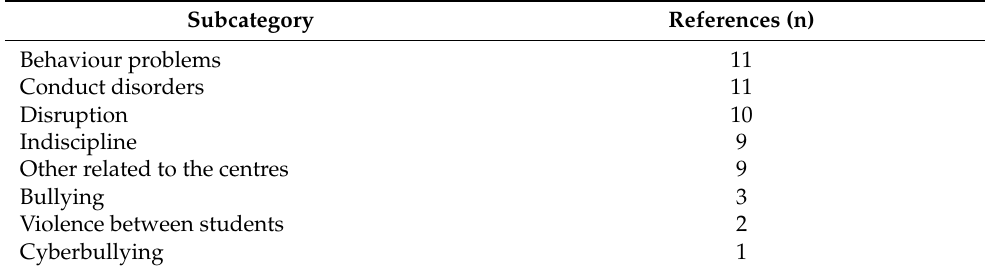
Table 7. Analysis of category 2. Main conflicts.